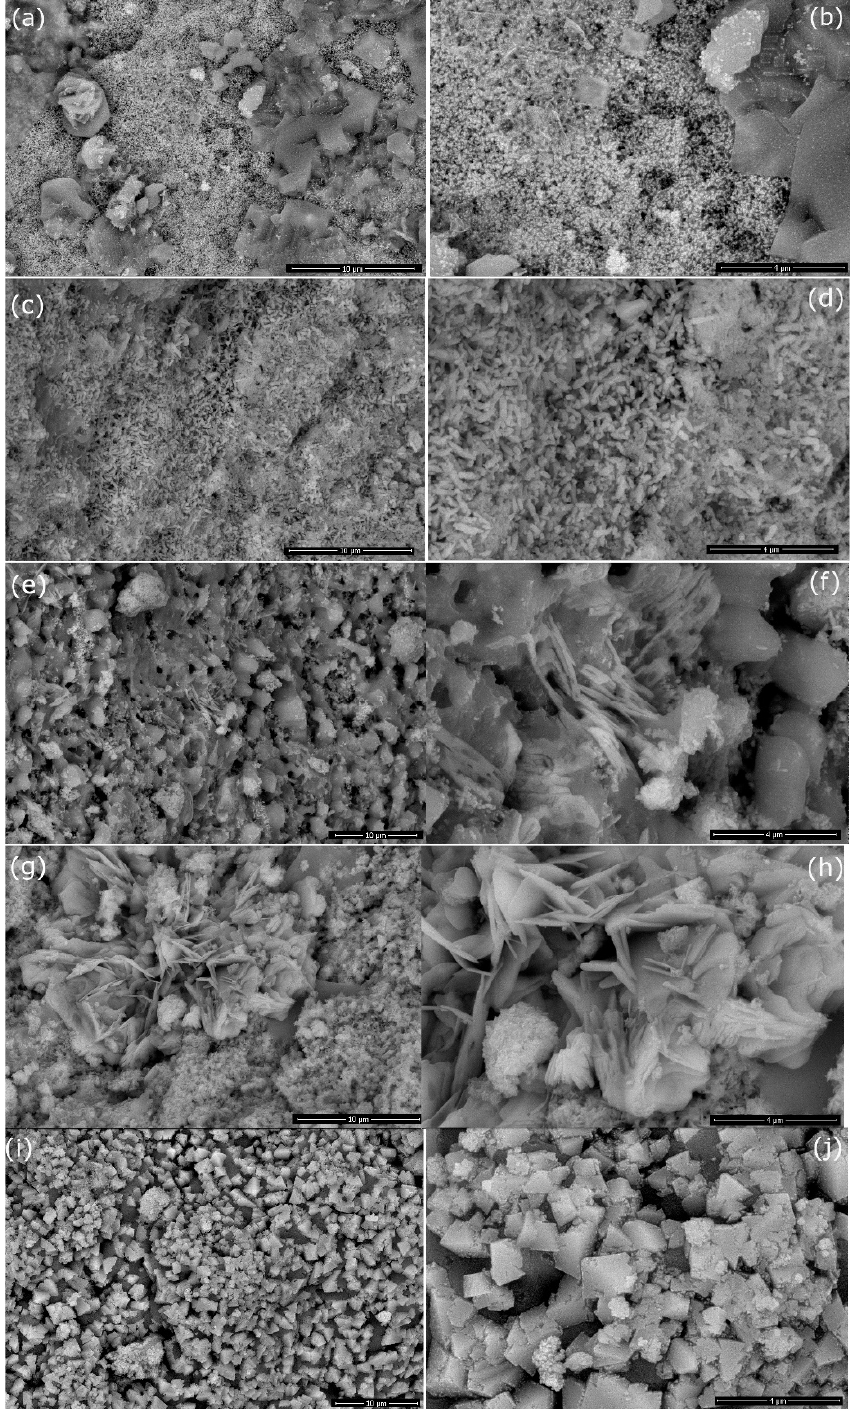
Figure 5. The SEM photos of the ZC0 ( a , b ), ZC25 ( c , d ), ZC50 ( e , f ), ZC75 ( g , h ), and ZC100 ( i , j ) sam- ples.